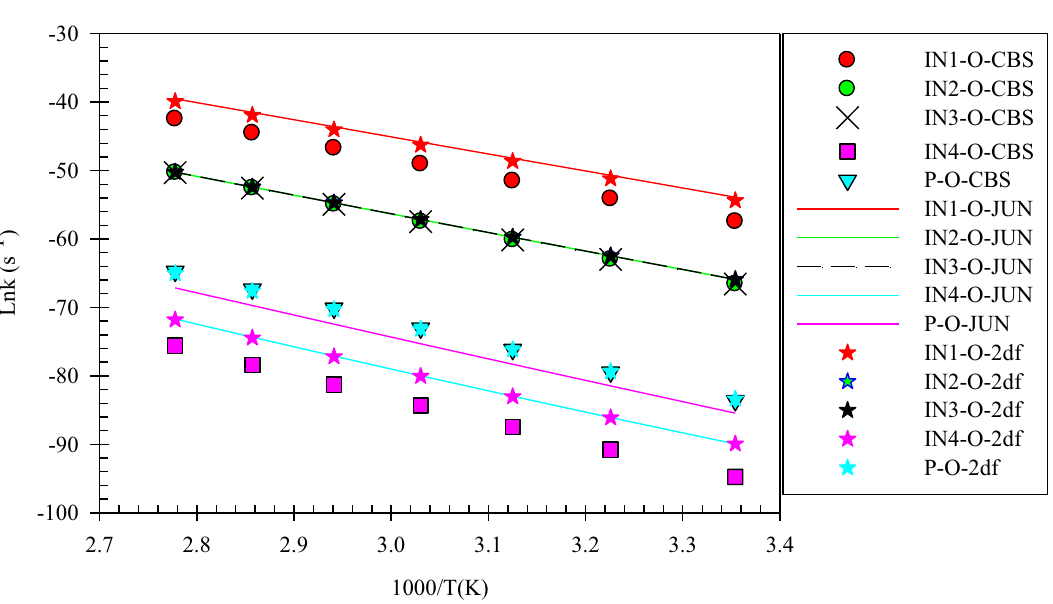
Figure 6. Overall rate constants for production of all minimum stationary points in 3-hydroxyfuran-2(5H)-one unimolecular reaction computed at three different levels over 298.15–360 K temperature